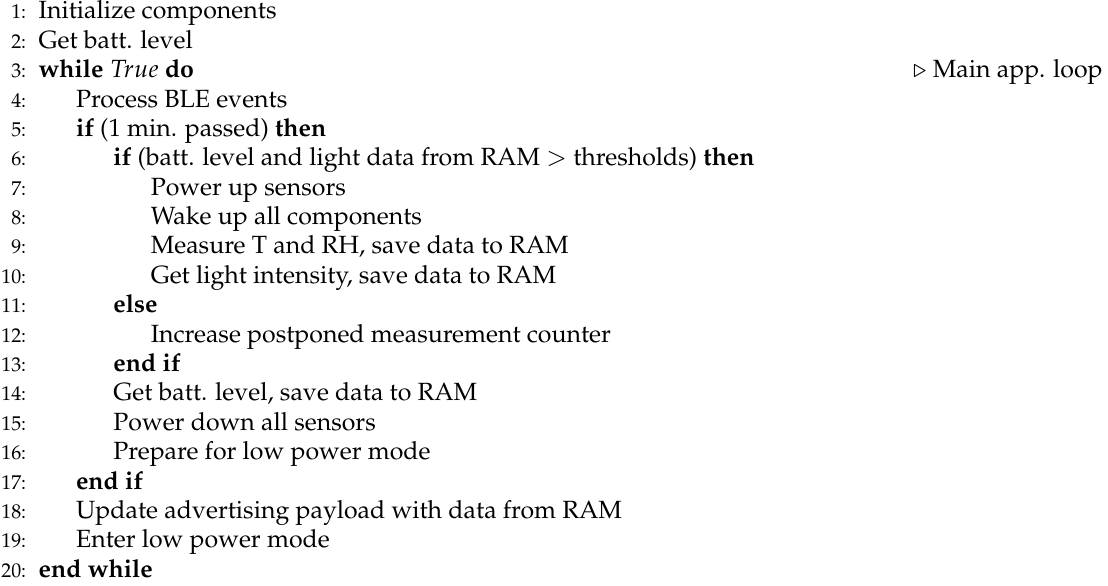
Algorithm 4 Wireless sensor measuring T, RH, and light